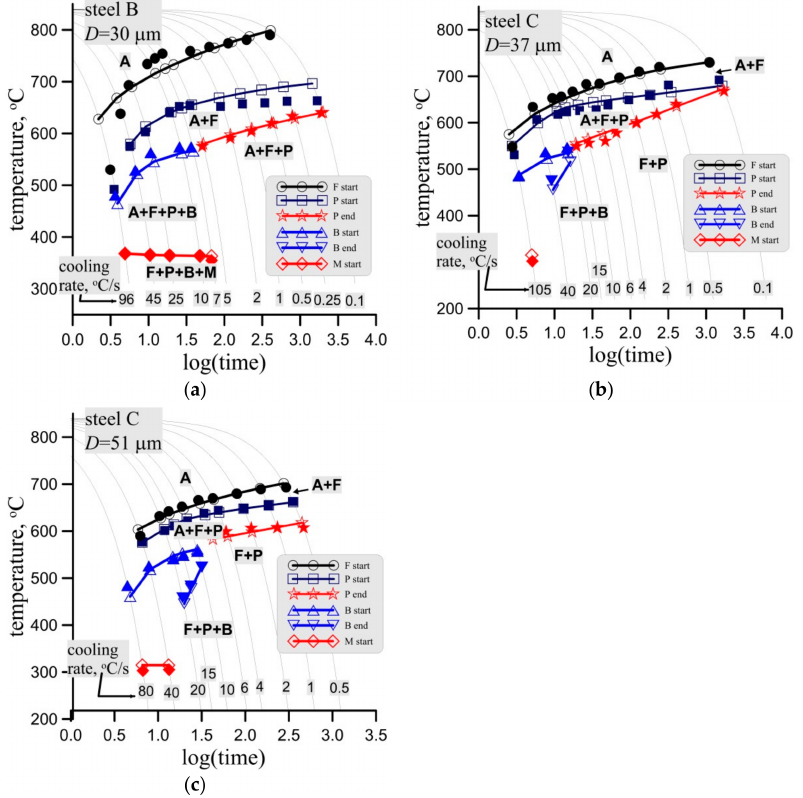
Figure 15. Measured (full symbols) and calculated (open symbols with lines) start and end temper- atures of phase transformations in the CCT tests for steel B, grain size 30 ± 3 µ m, ( a ) and steel C, grain size 37 ± 4 µ m ( a ) and 51 ± 3 µ m ( c